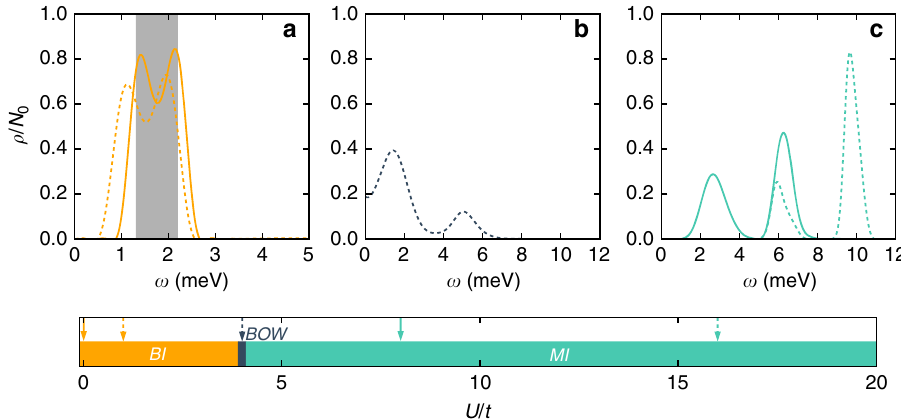
Fig. 3 Density of states in twisted bilayer GeSe at μ ¼ 0 obtained from DMRG. The bottom scale shows the different phases found in dependency of U = t at half fi lling μ ¼ 0. Arrows indicated the vales U = t used to calculate the density of states shown in the upper panels ( U = t ¼ 0 ; 1 in a , U = t ¼ 4 in b and U = t ¼ 8 ; 16 in c ), which are grouped corresponding to the phases (BI, BOW or MI in a , b or c , respectively). In a a shaded region indicates the position of the non-interacting band edges, which agrees well with our numerics, where the density of states is found via real-time propagation. Consistent with Fig. 2, we fi nd a non-monotonic gap size in the density of states as U = t is increases, fi rst decreasing and then increasing. Close to U ¼ 0 the gap is determined by (cid:5) ϵ U it scales (cid:5) U . The temperature in these calculations are T ¼ 1 : 2 K for a , c , as well as T ¼ 2 : 4 K for b . (Here N 0 while at large over the density of states to